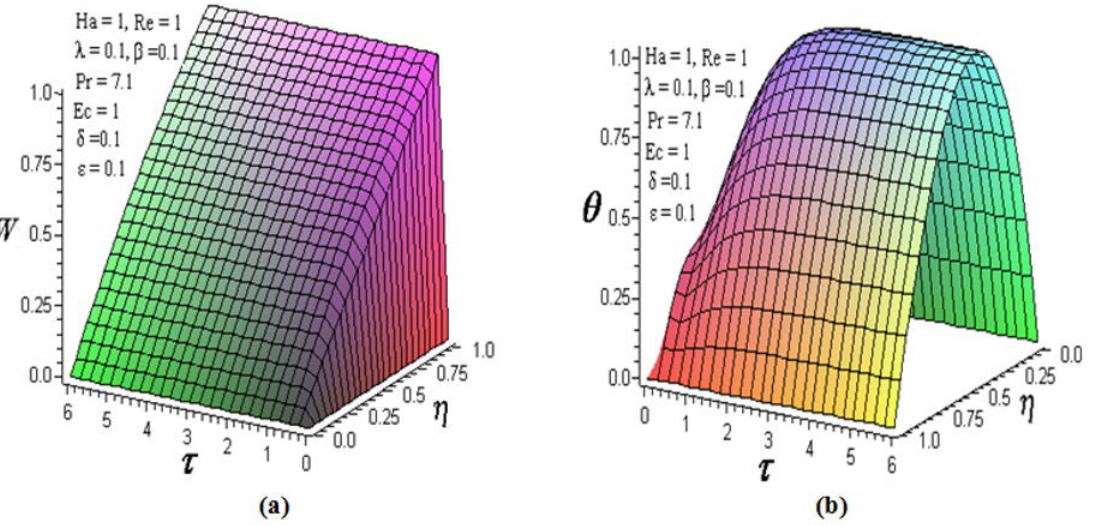
Figure 2. Fluid velocity and temperature profiles across the channel with increasing time